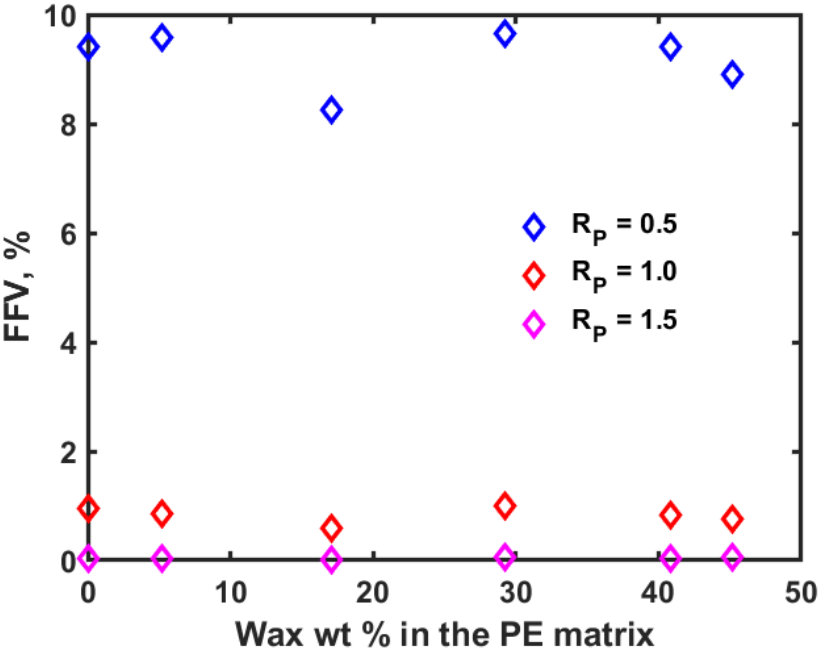
Figure 9. Fraction of free volume in % vs. the weight % of wax in the PE matrix with different probe radii (R P in Å).